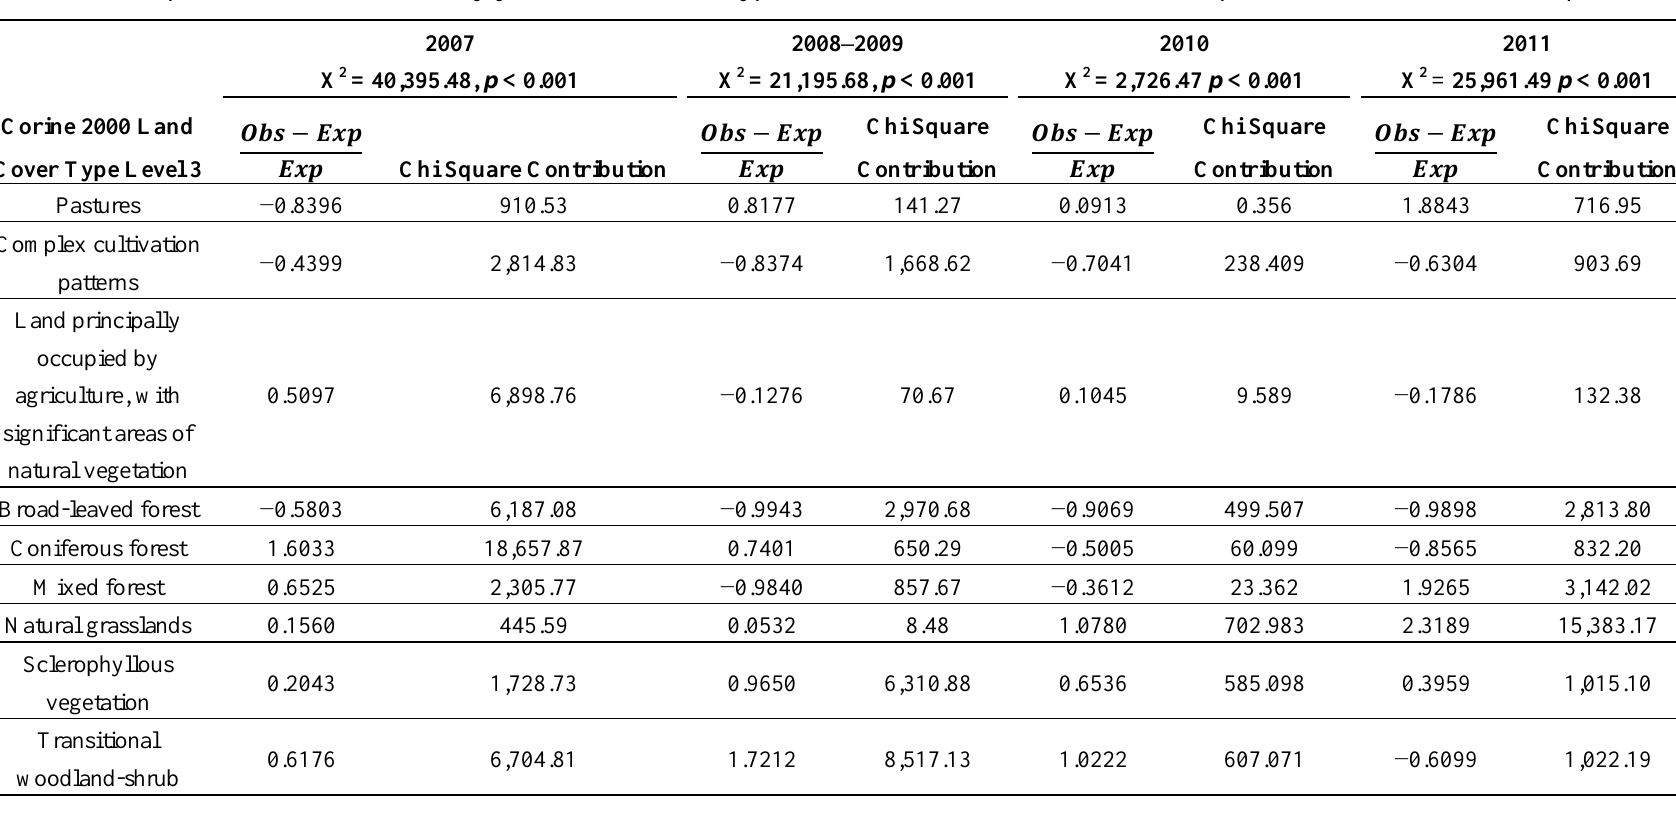
Table 4. Chi-square results for each study year and landcover type. Positive values in the Observed-Expected column indicates fire proneness.